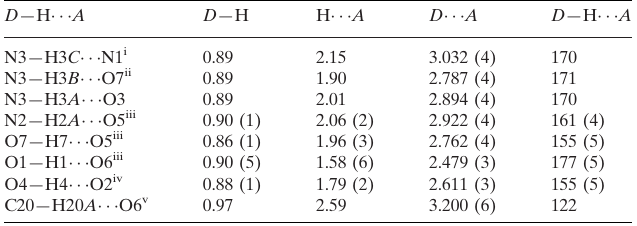
Hydrogen-bond geometry (A˚ , (cid:3) ).